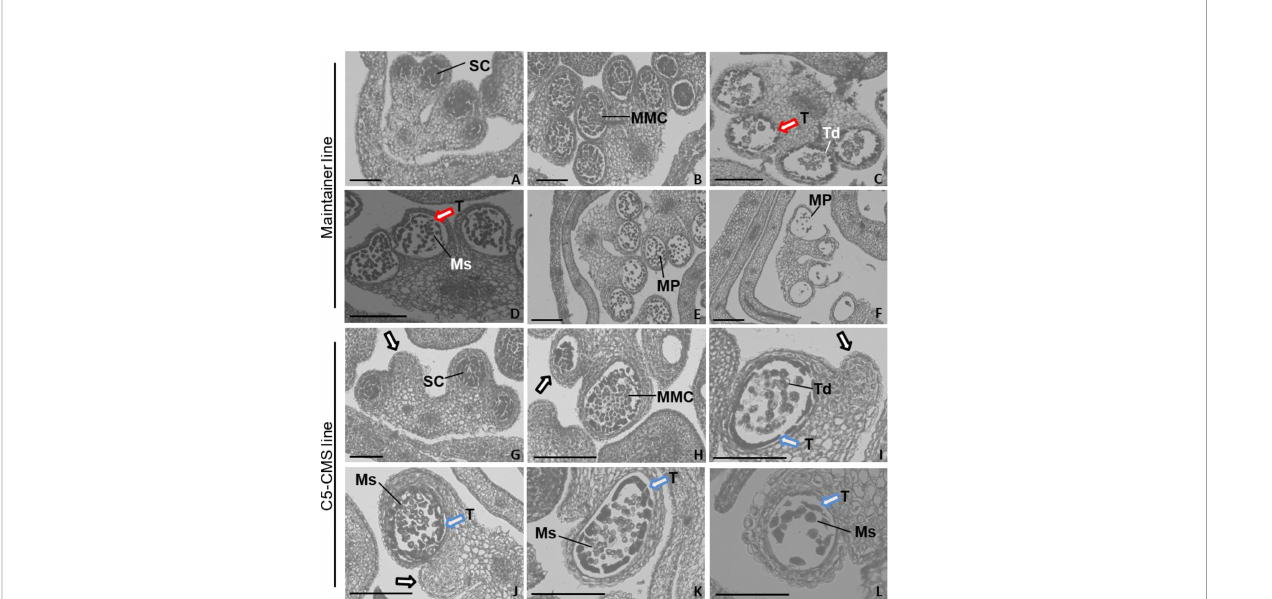
FIGURE 10 Comparative histology of anther development in B . oleracea maintainer and C5-type CMS lines. Histology of anther development in the maintainer line (A – F) and C5-type CMS line (G – L) . (A, G) are the sporogenesis cell stage; (B, H) are the microspore mother cell stage; (C, I) are the tetrad stage; (D, J) are the uninucleate microspore stage; (E, K) are the mature pollen stage; and (F, L) are the anthesis stage. SC, sporogenesis cell; MMC, microspore mother cells; T, tapetum; Td, tetrad; Ms, microspore; MP, mature pollen. Bar = 200